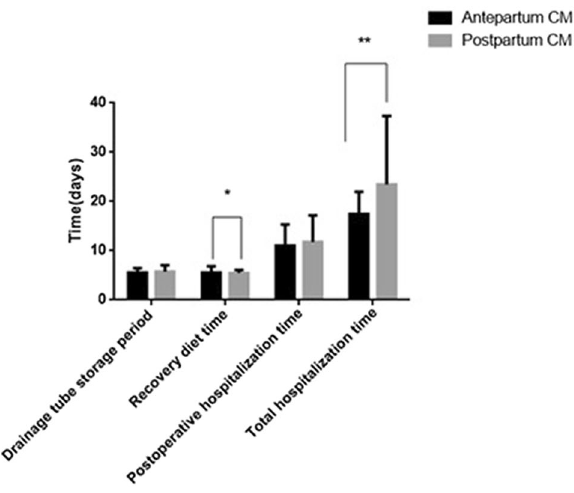
Figure 9. Comparison of the drainage tube storage period, recovery diet time, postoperative hospitalization time and total hospitalization time after the operation between prepartum-diagnosed CM and postpartum- diagnosed